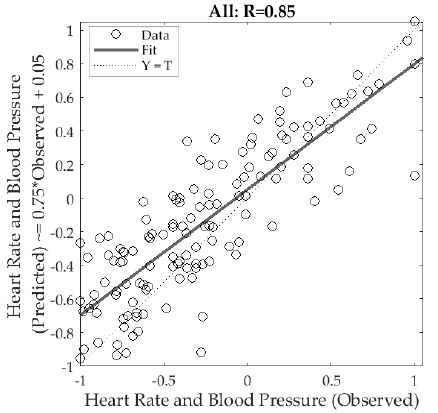
Figure 7. The artificial neural network regression overall model (Model 1) showing a high correlation coefficient (R = 0.85), where the x-axis represents the observed (targets) and the y-axis represents the predicted (outputs) values of heart rate (HR) and blood pressure (BP) measured with the oscillometric monitor. All values were normalized in a scale from −1 to 1. Table 1. Statistical results of Model 1 showing the number of samples, mean squared error (MSE) and correlation coefficient (R) for the training, validation and testing stages as well as the overall model.